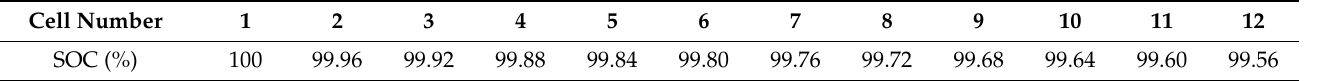
Table 2. The SOCs of battery cells.